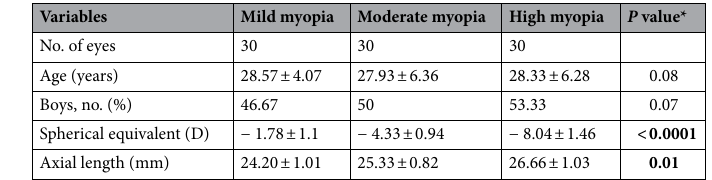
Table 1. Basic data of three groups of subjects. Significant P values are in bold.